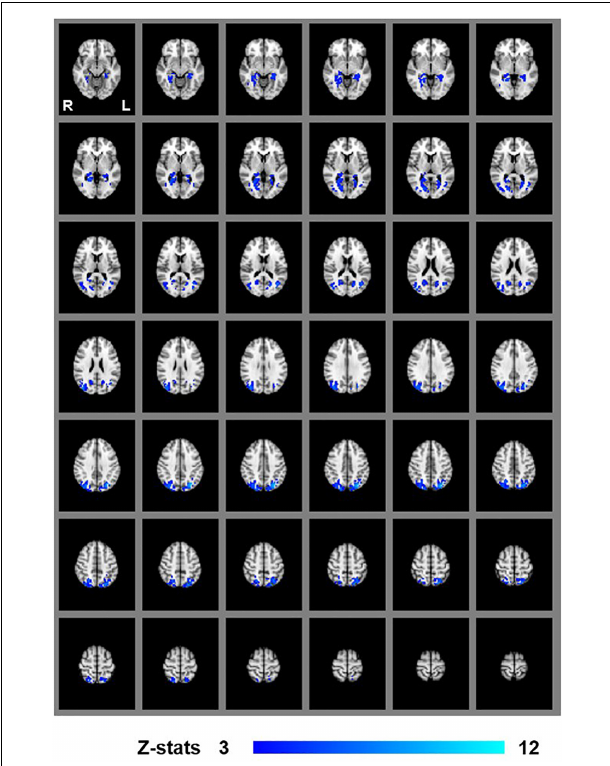
FIGURE 3 | Group results for monocular-aperture viewing, revealed by the fixed-effects ( N = 7) GLM contrast [MaP INTACT > MaP SCRAMB images]. All responses are masked to gray matter. Uncorrected p < 0.001.